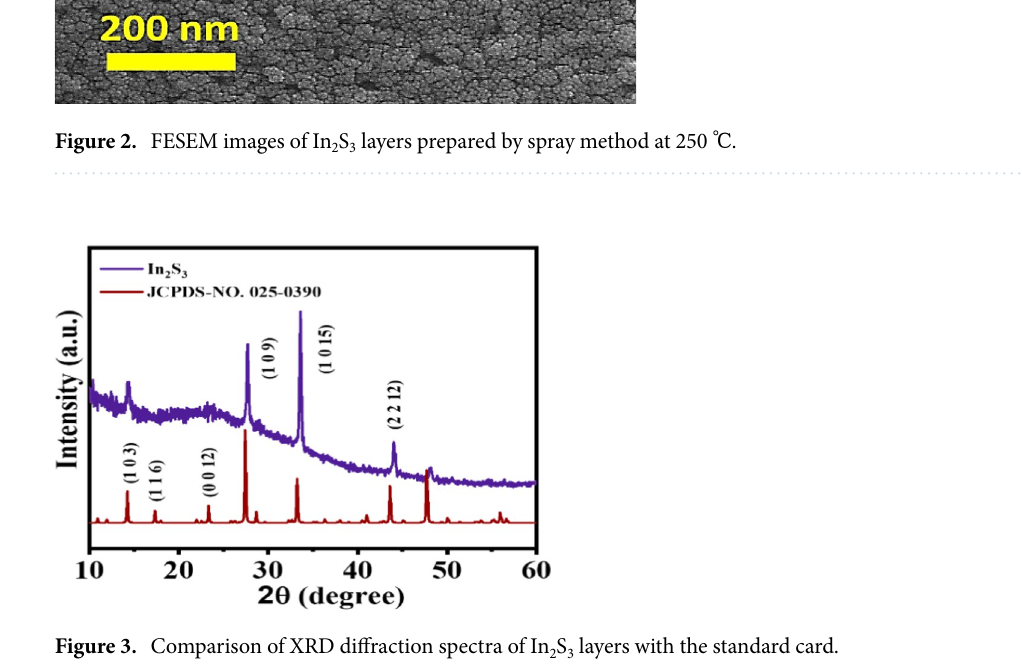
Figure 3. Comparison of XRD diffraction spectra of In 2 S 3 layers with the standard